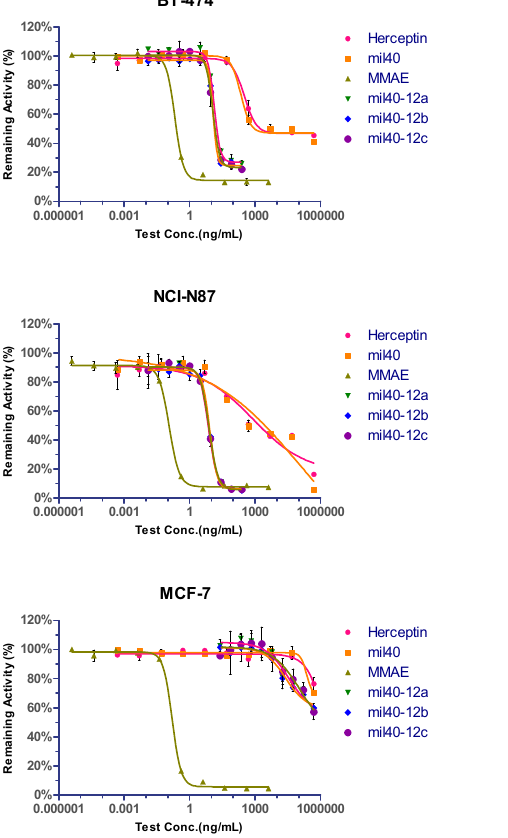
Figure 6. Cytotoxicity and selectivity of ADCs in tumor cells in vitro. Cytotoxicity assay performed in HER2-positive, weakly positive and negative cell lines. Breast cancer cell lines BT-474 and SK-BR-3, gastric cancer cell line NCI-N87, and ovarian cancer cell line SK-OV-3 were HER2-positive. Breast cancer cell lines MCF-7 and MDA-MB-468 were HER2-weakly positive and -negative, respectively. Each group was established three holes and results are shown as mean ± SD. IC 50 is presented on Table